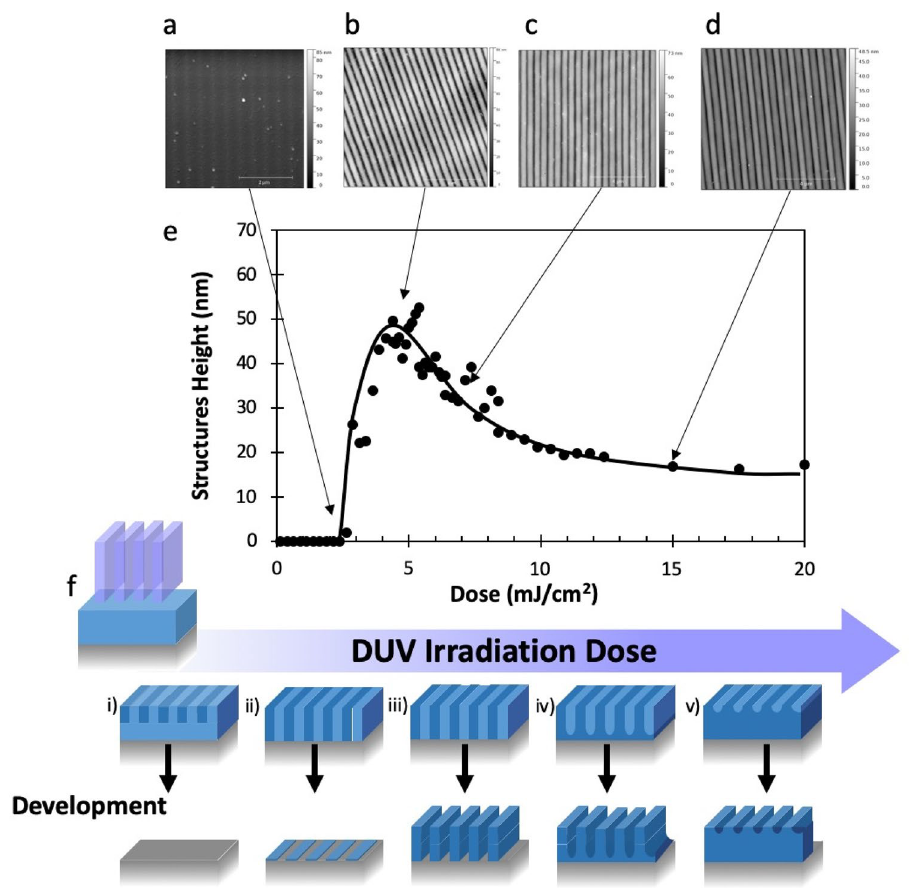
Figure 7. AFM images of patterns written with various doses in interferometric configuration: ( a ) 2.5 mJ/ cm 2 , ( b ) 5 mJ/cm 2 , ( c ) 7.5 mJ/cm 2 , ( d ) 15 mJ/cm 2 . Period 500 nm. ( e ) Variation of the pattern height with the dose. ( f ) Schematic interpretation of the evolution of the pattern structure with the irradiation dose. Initial film thickness 80 nm. The solution has a molar ratio Si/Ti = 6/1 and the MNPs concentration was 0.4